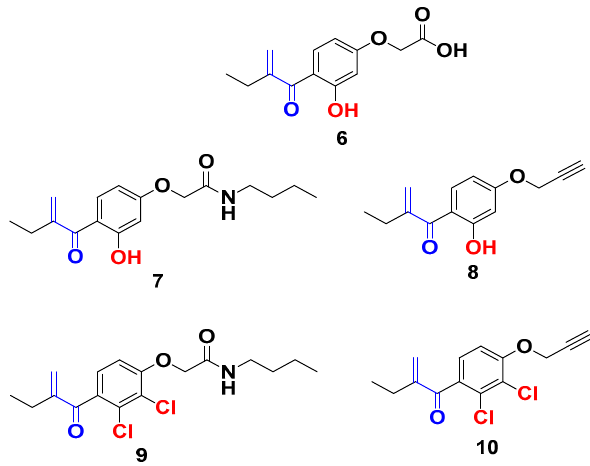
Figure 2. New EA family selected for antiproliferative activity tests. Table 2. Antiproliferative activity of compounds 7 , 8, and doxorubicin upon various cancer human cells and normal cells expressed in terms of IC 50